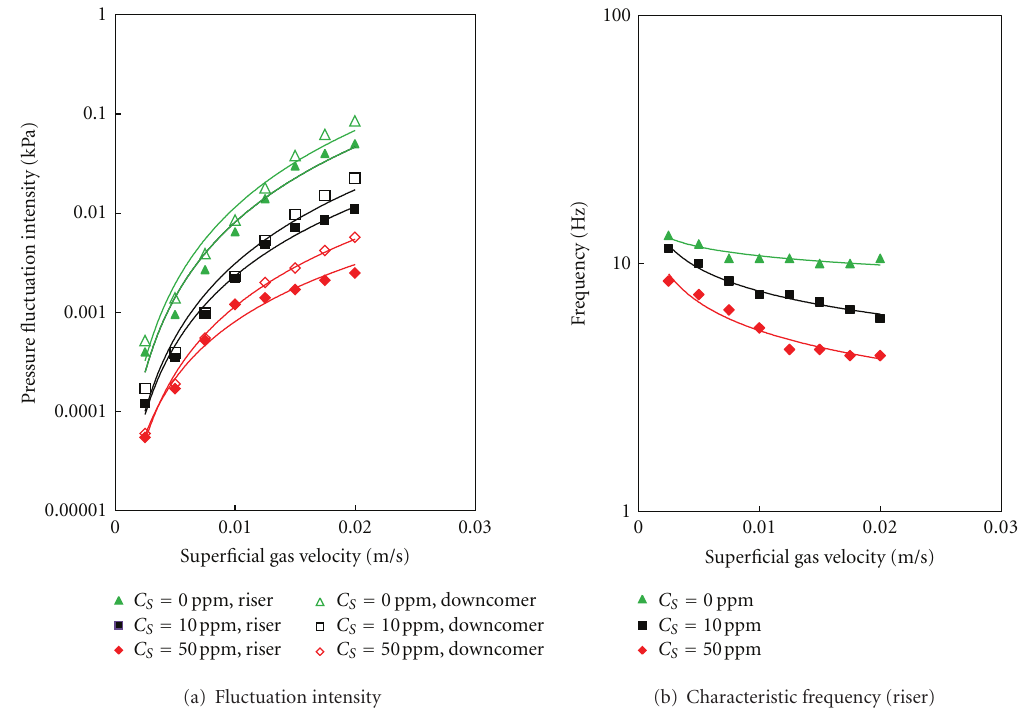
Figure 6: E ff ect of superficial gas velocity and surfactant concentration on the intensity and characteristic frequency of pressure fluctuations ( Δ P S = 280